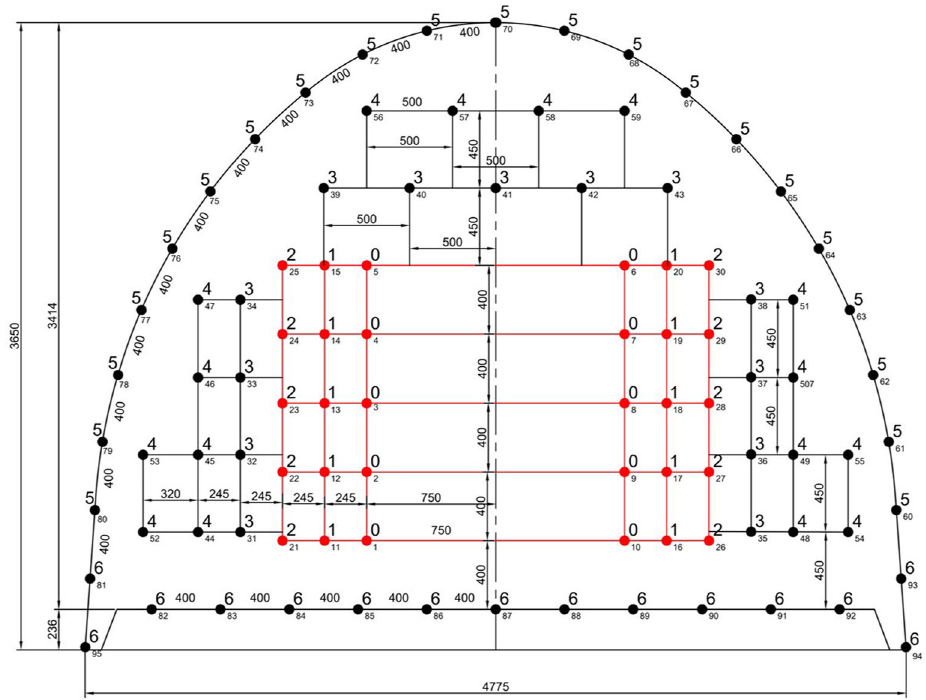
Figure 13. The arrangement of blastholes and firing sequences in excavation of 12.5 m 2 cross-section for a single V cut